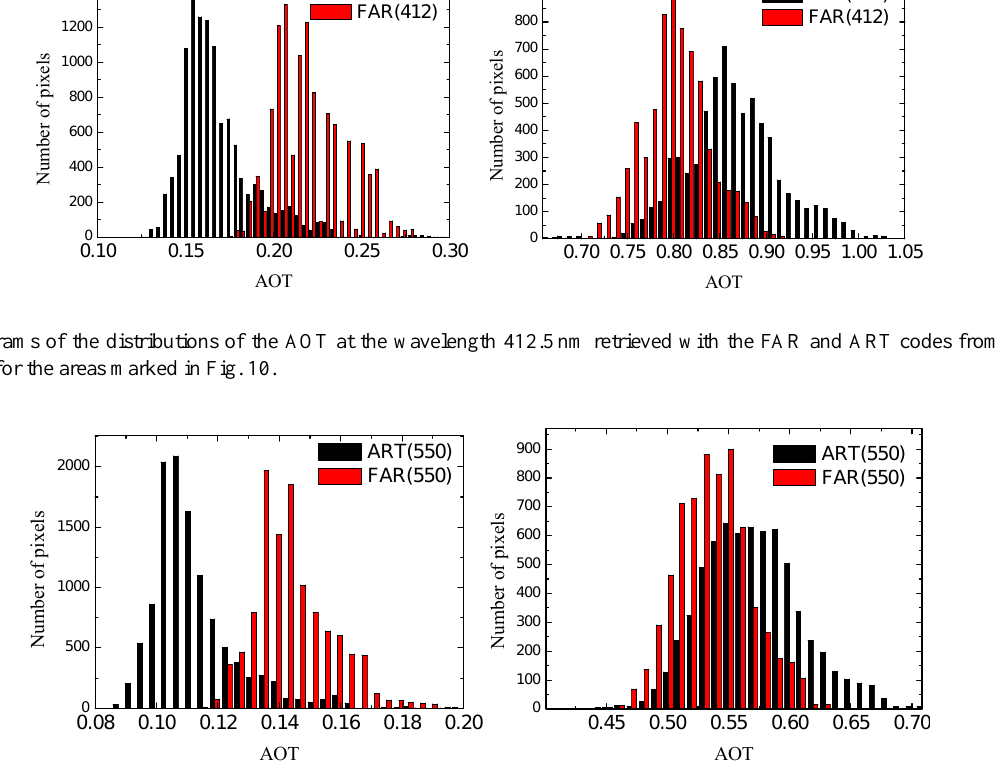
Fig. 15. Histograms of the distributions of the AOT at the wavelength 550nm retrieved with the FAR and ART codes from MERIS on ENVISAT data for the areas marked in Fig.